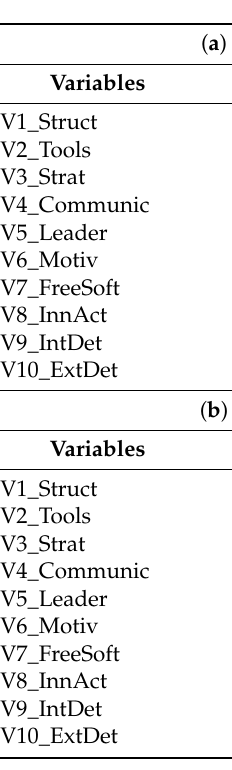
Table 6. ( a ) Correlations with the original variables/Analysis of Results. ( b ) Correlations with the original variables/Analysis of